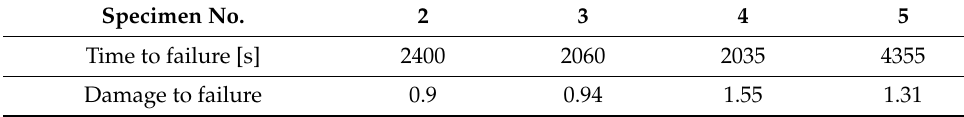
Table 10. Cumulative damage computed by Miner’s rule for the FCC specimens. Specimen